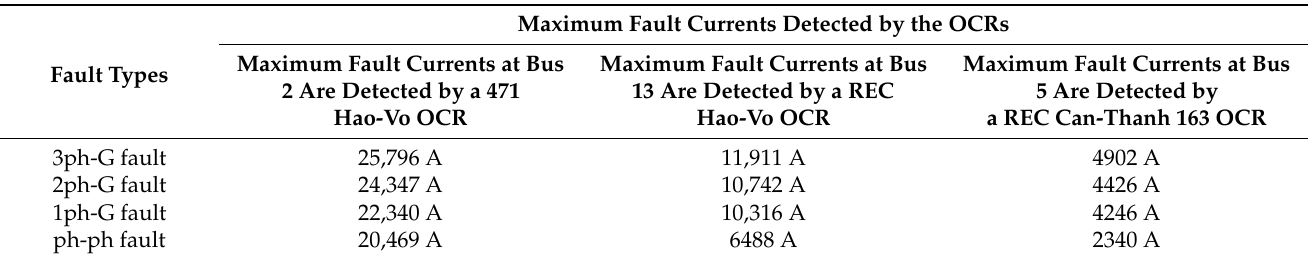
Table 2. Numerical fault-current calculation results are seen by the OCRs in a considered feeder of the DG-based DN. Maximum Fault Currents Detected by the OCRs Maximum Fault Currents at Fault Types